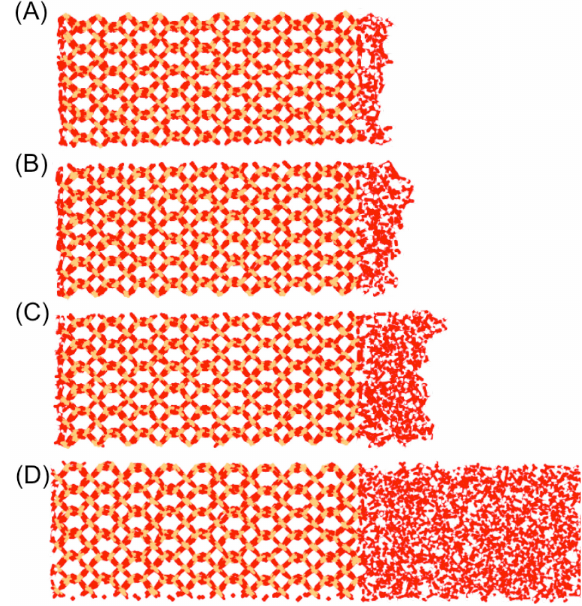
Figure 1. A single quartz|water slab (half of the simulation box) for ( A ) 1H of hydration (monolayer); ( B ) 2 H level of hydration (tetralayer); and ( D ) bulk